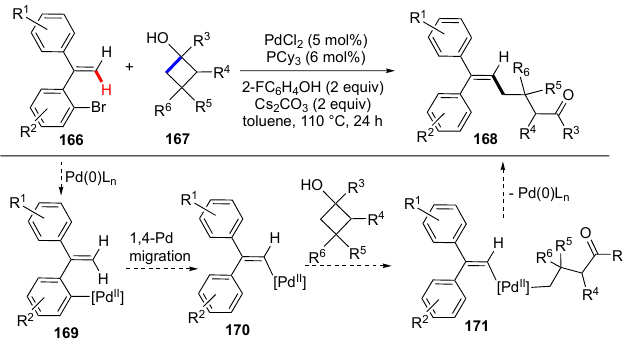
Scheme 20. Functionalization of gem- diaryl alkenes through 1,4-Pd migration.